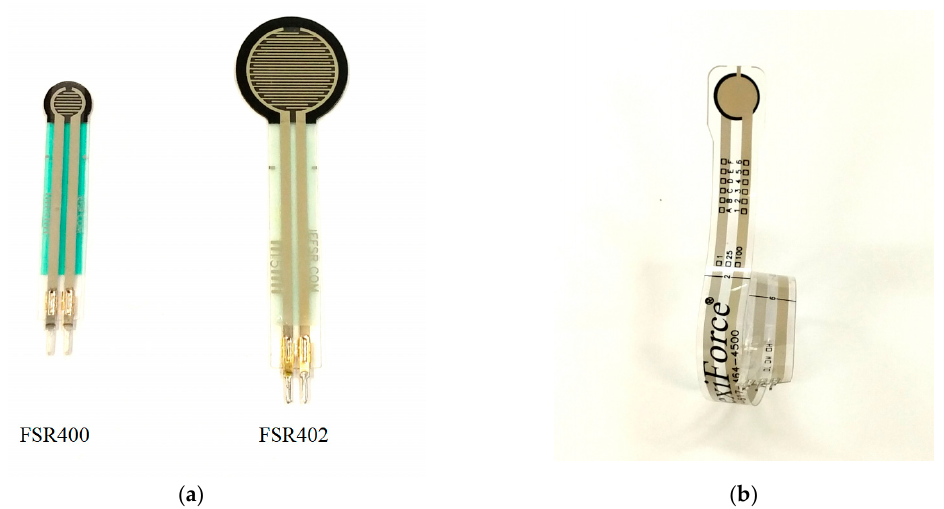
Figure 3. An example of the elementwise polymer thick film sensors ( a ) FSR sensors; ( b ) Flexiforce ® sensor.